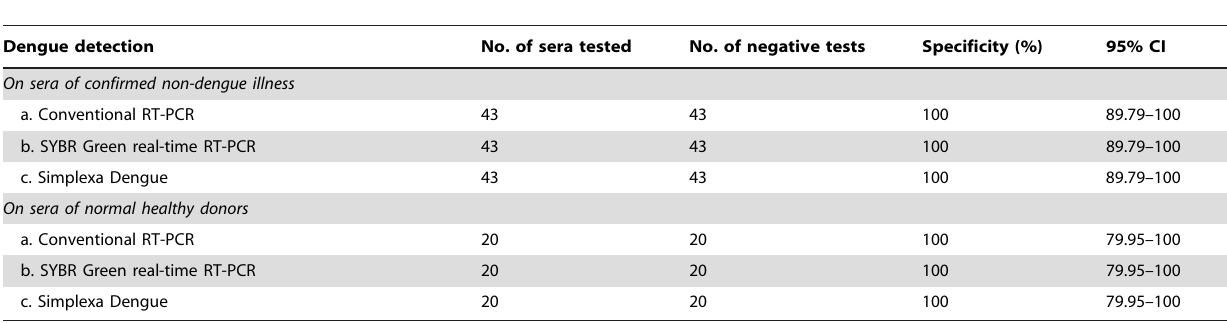
Table 2. Specificity of conventional RT-PCR, SYBR Green real-time RT-PCR, and Simplexa Dengue on non-dengue illness and healthy human